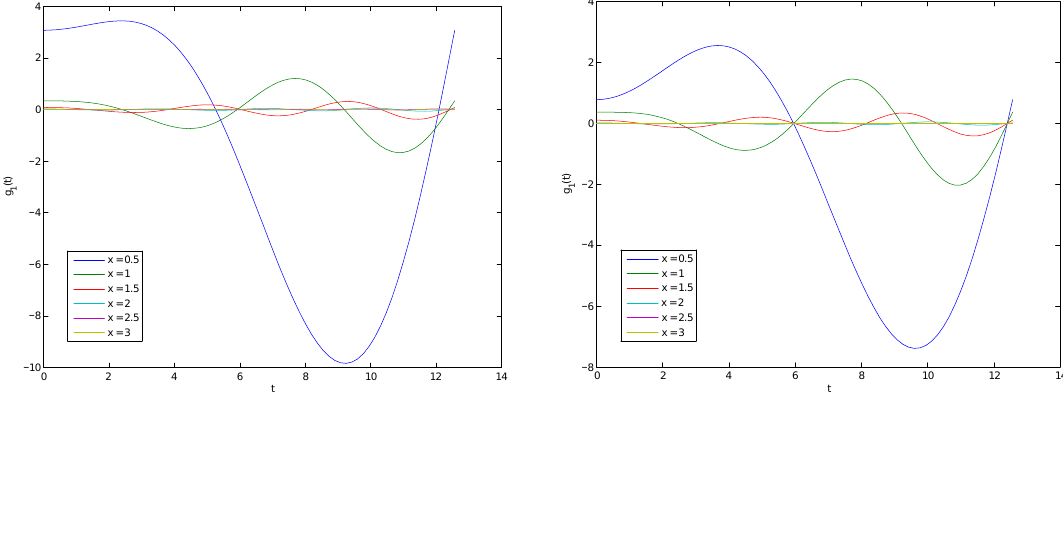
Fig. 3. Exact (top) and approximate (bottom) cross section solution g.t/ when ˛ D 0:8 and g 0 .x/ D e (cid:0) x